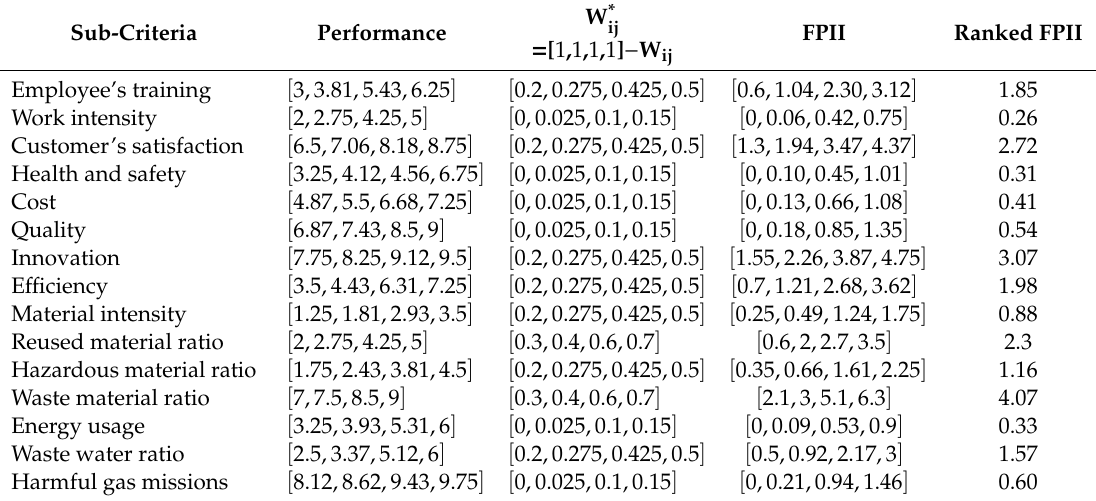
Table 11. The fuzzy performance importance indexes and ranking